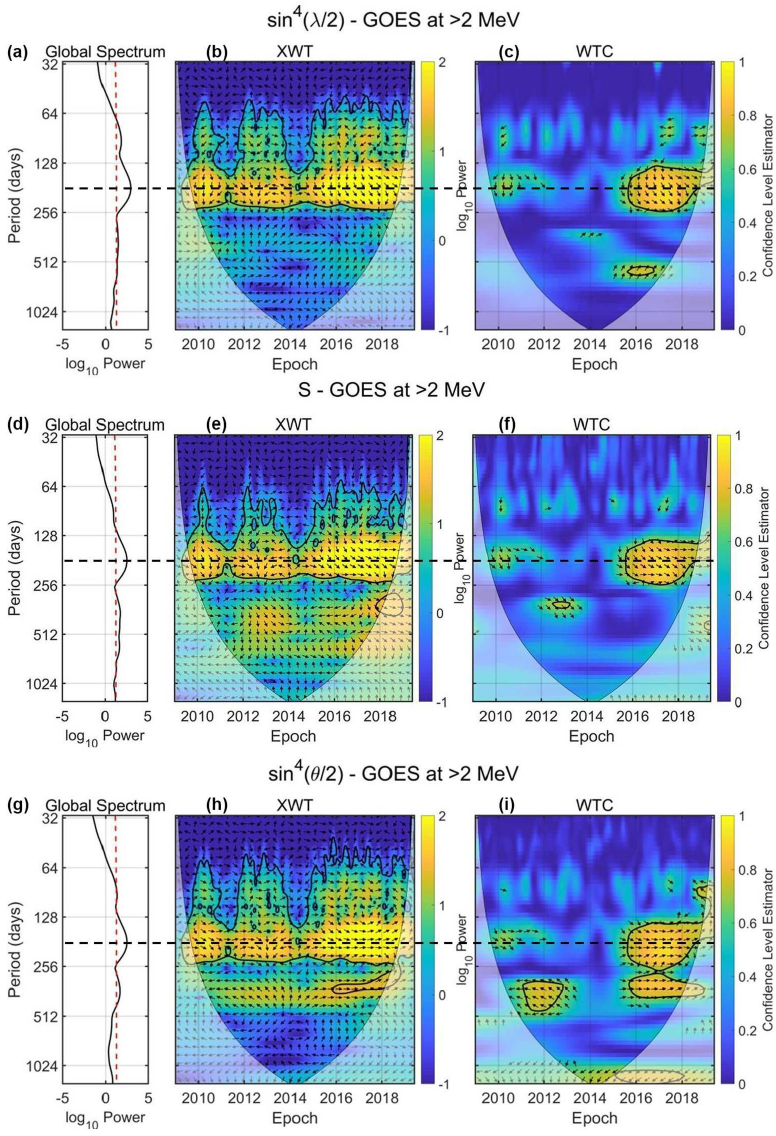
Figure 5. Global wavelet ( a , d , g ), cross-wavelet transformation (XWT; b , e , h ) and wavelet coherence (WTC; c , f , i ) between the > 2 MeV electron flux from GOES/EPS and the lambda function ( a – c ) that controls the axial effect, the S function ( d – f ) that controls the equinoctial effect and the θ function ( g – i ) that controls the Russell–McPherron; the dashed red line corresponds to the 95% confidence level of the global wavelet. The thick black contours mark the 95% confidence level, and the thin line indicates the cone of influence (COI). The colour bar of the XWT indicates the log10 (power); the colour bar of the WTC corresponds to the confidence level of the phase obtained by the Monte Carlo test, and the arrows correspond to a confidence level > 0.6. The arrows point to the phase relationship of the two data series in time–frequency space: (1) arrows pointing to the right indicate in-phase behaviour; (2) arrows pointing to the left indicate anti-phase behaviour; (3) arrows pointing downward indicate that the first dataset is leading the second (meaning that the first dataset occurs earlier in time) by 90 ◦ . The horizontal dashed (black) lines highlight the SAV. Source: Katsavrias et al. 2021